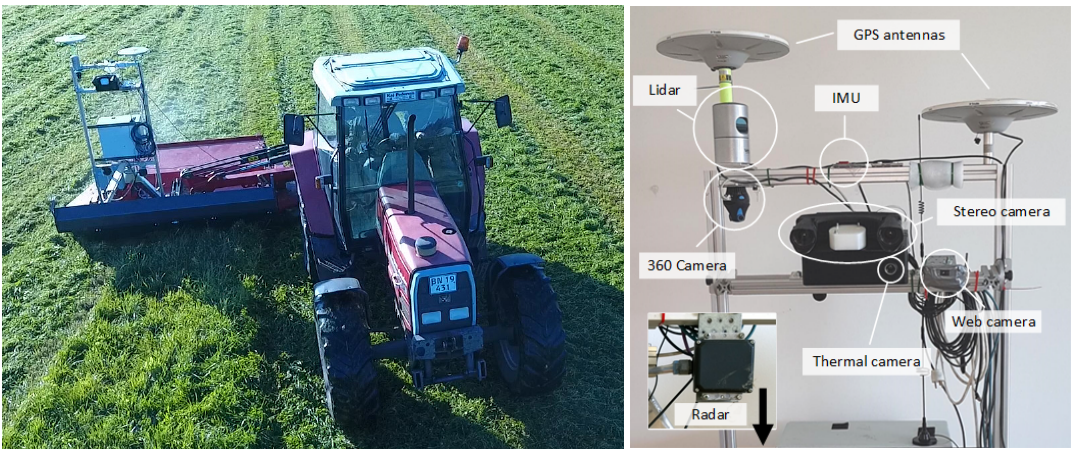
Figure 2. Recording platform. Table 2. Exteroceptive sensors.